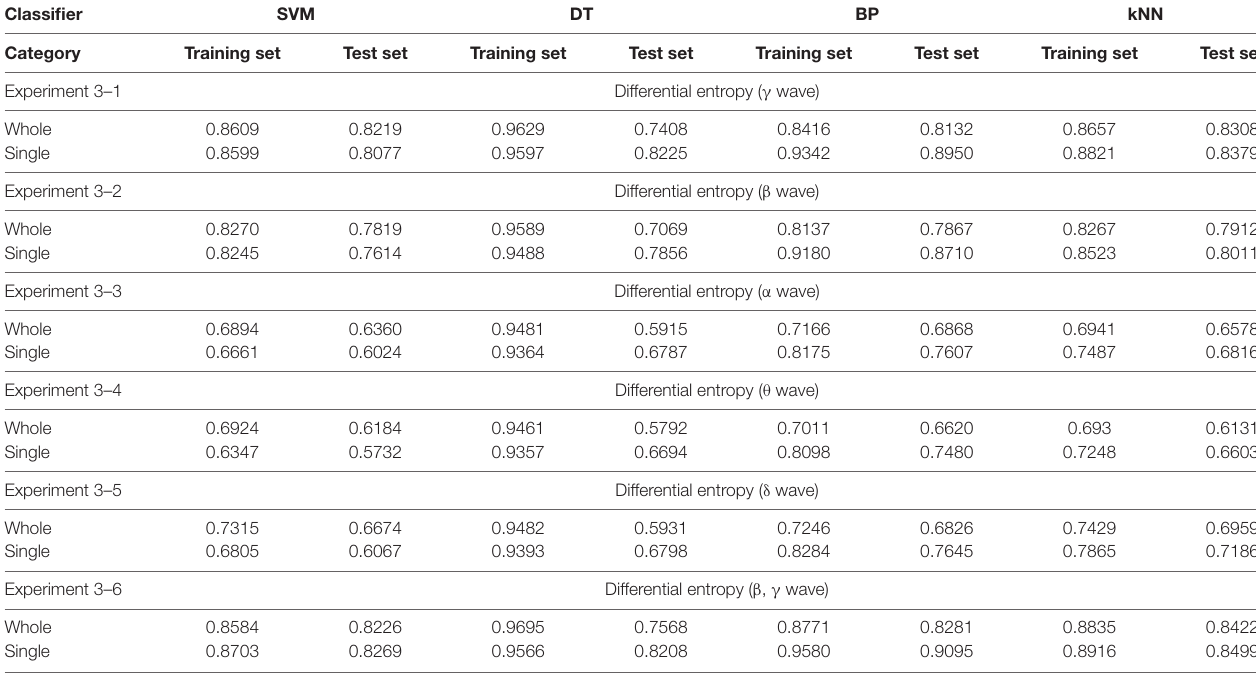
TABLE 4 | The effect of differential entropy in different frequency bands on emotion classification.